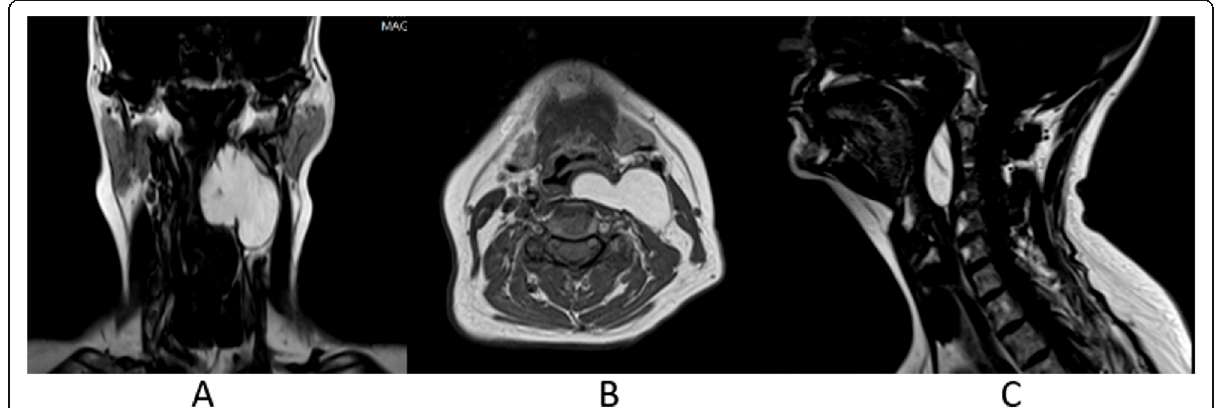
Fig. 3 MRI T1-weighted coronal ( a ), axial ( b ), and sagittal ( c ) images showing strong enhancement of the lesion. Impingement on the airway